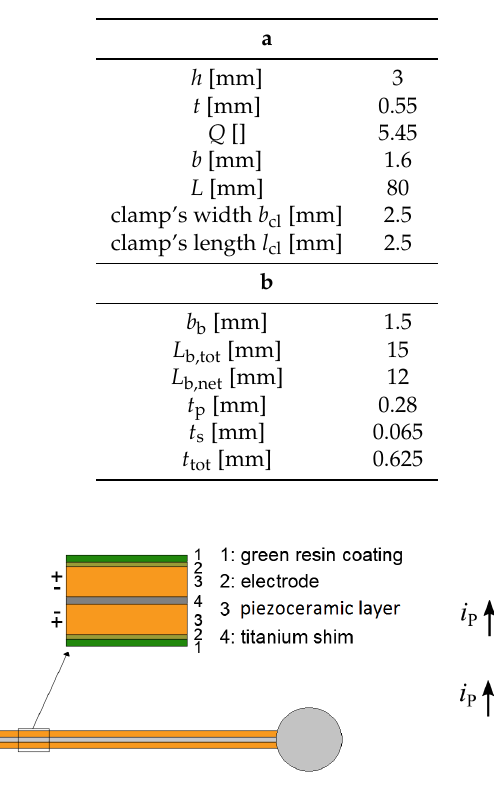
Table 1. Nominal dimensions of the bistable mechanism (a) and of the bimorph piezoelectric beam (b).